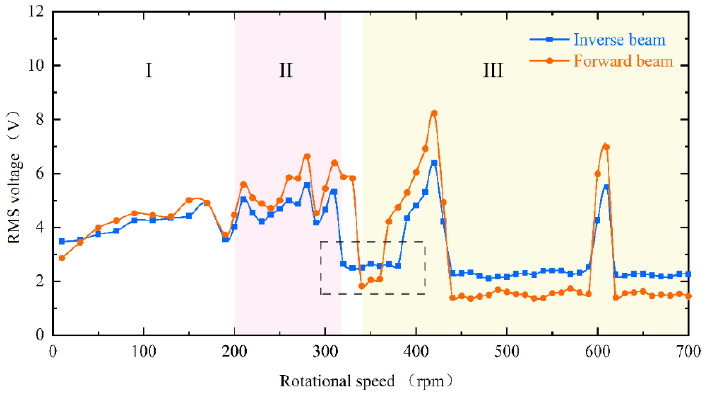
10 of 17 Figure 8. Experimental results of RMS voltage for the inverse beam at magnet spacing of 8 mm (blue line) and 10 mm (red line). The energy harvester is divided into upper and lower parts, with the piezoelectric beam installed inverse and forward, respectively, and in Figure 9 their RMS voltages can still be divided into three regions with similar trends. However, the black dotted square in the figure shows a difference in the low-energy-harvesting region. According to the difference in mounting, it can be known that the two piezoelectric beams are subjected to magnetic forces in opposite directions at the tips and gravity is vertically downward, which causes the combined forces on the tips to be different. As shown in Figure 10a, because the component force of gravity and the component force of magnetism are in op- posite directions, the force perpendicular to the inverse beam is reduced. At the same time, gravity also gives the beam a hardening effect, which is not helpful for the vibration of the